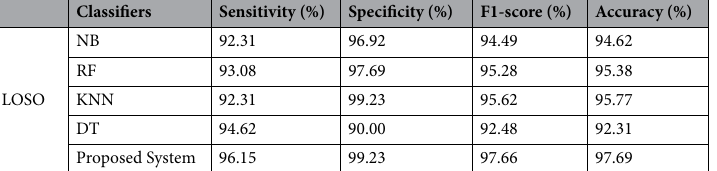
Table 6. Classification accuracy of the proposed system compared with different machine learning classifiers. Note that: NB, RF, KNN, DT, SVM, and LOSO stand for Naïve Bayes, random forest, K-nearest neighbors, decision tree, support vector machine, and leave-one-subject-out,